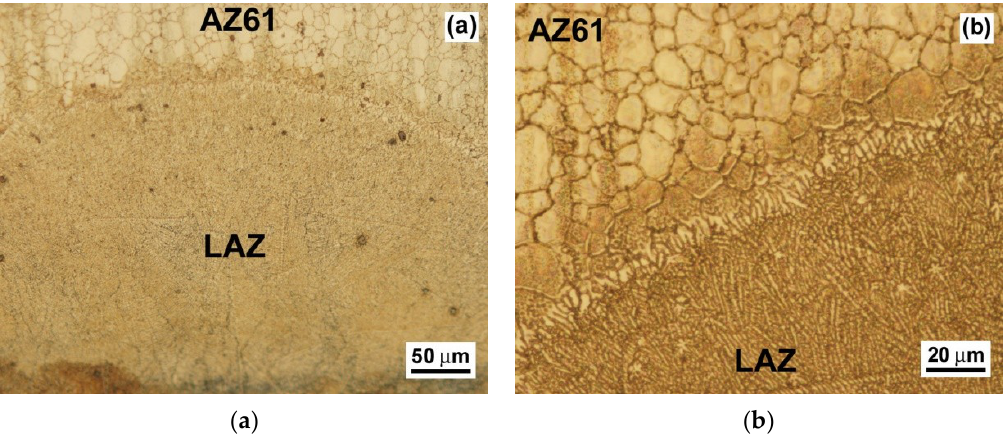
Figure 3. Detailed light-optical micrographs of the LAZ microstructure created using currently optimized laser surface treatment of AZ61 base material: ( a ) whole LAZ microstructural gradient and ( b ) interfacial region between the LAZ and unaffected AZ61 base material.